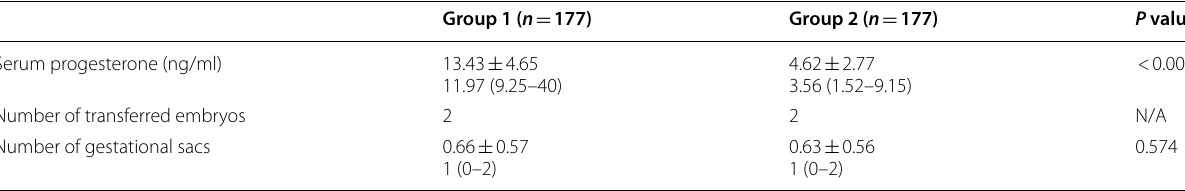
Table 2 Characteristics of IVF cycles